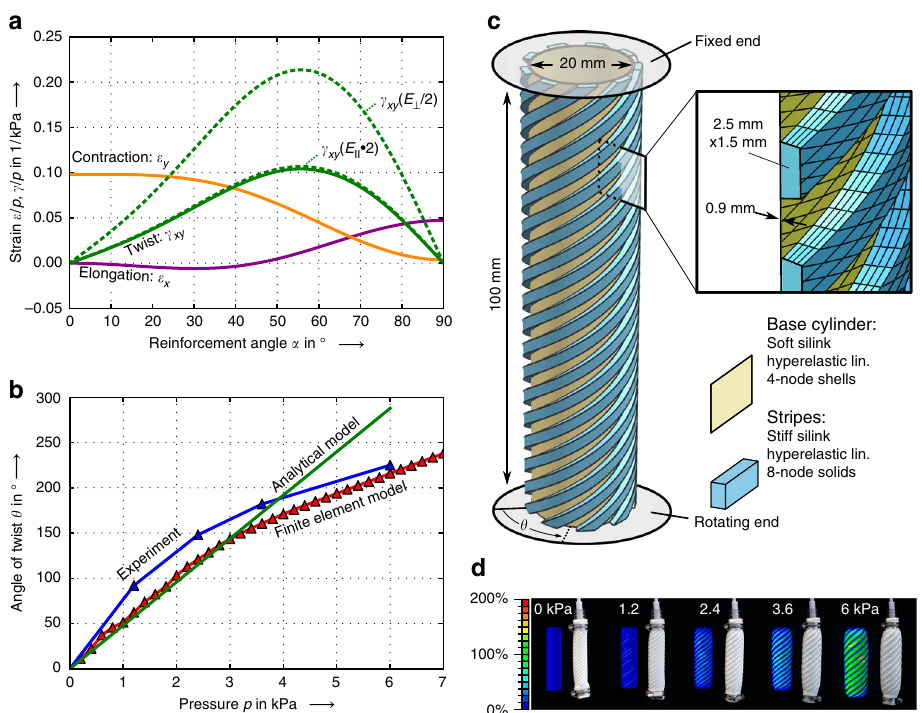
Fig. 4 Model predictions of the morphing behavior of soft actuators exhibiting bioinspired multimaterial architectures. a Analytical prediction of strains over the lead angle of the stiff stripes in a pressurized cylinder. Small angles lead predominantly to contractile motion, large angles to elongation, and diagonal angles to twist. To increase the ef fi ciency of the motion mode twisting, a reduction of the transverse stiffness by 50% is signi fi cantly more effective than doubling the parallel stiffness. b Predicted and experimentally measured twist angle as a function of the applied internal pressure. c Geometry, simulation parameters, and fi nite element model of the 45° twister. d Calculated fi rst principal strain distribution and soft actuator shapes compared to experimental